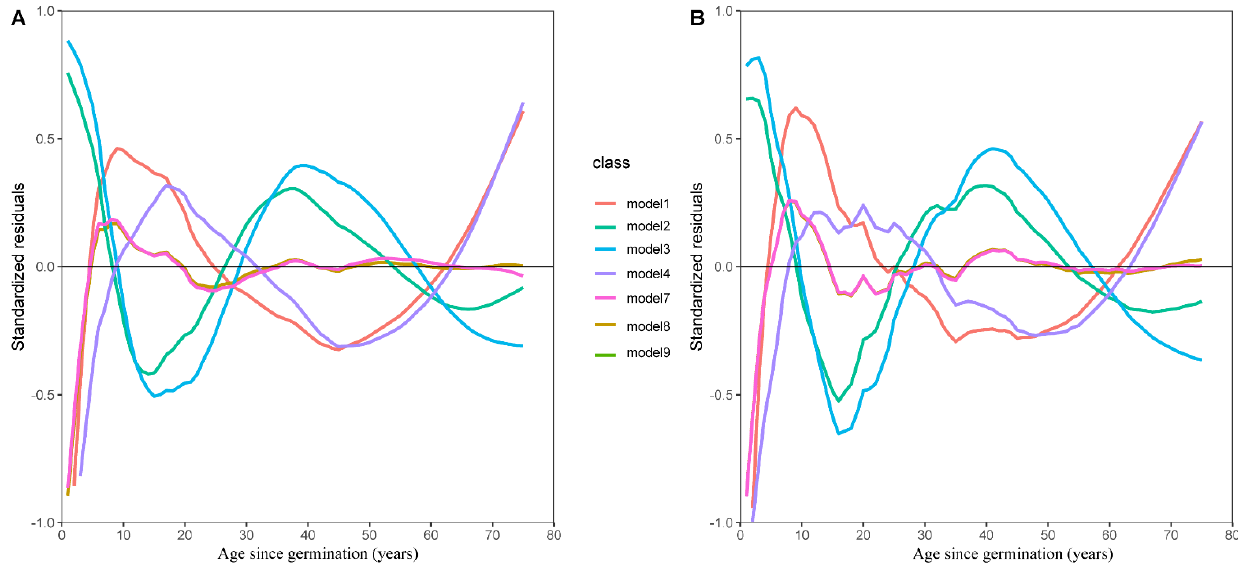
Figure 3. Residuals of the models fitted to the stem analysis data. ( A ) represents the model fitting data and ( B ) represents the model validation data. Mean residuals (solid line) were calculated for the same age class.